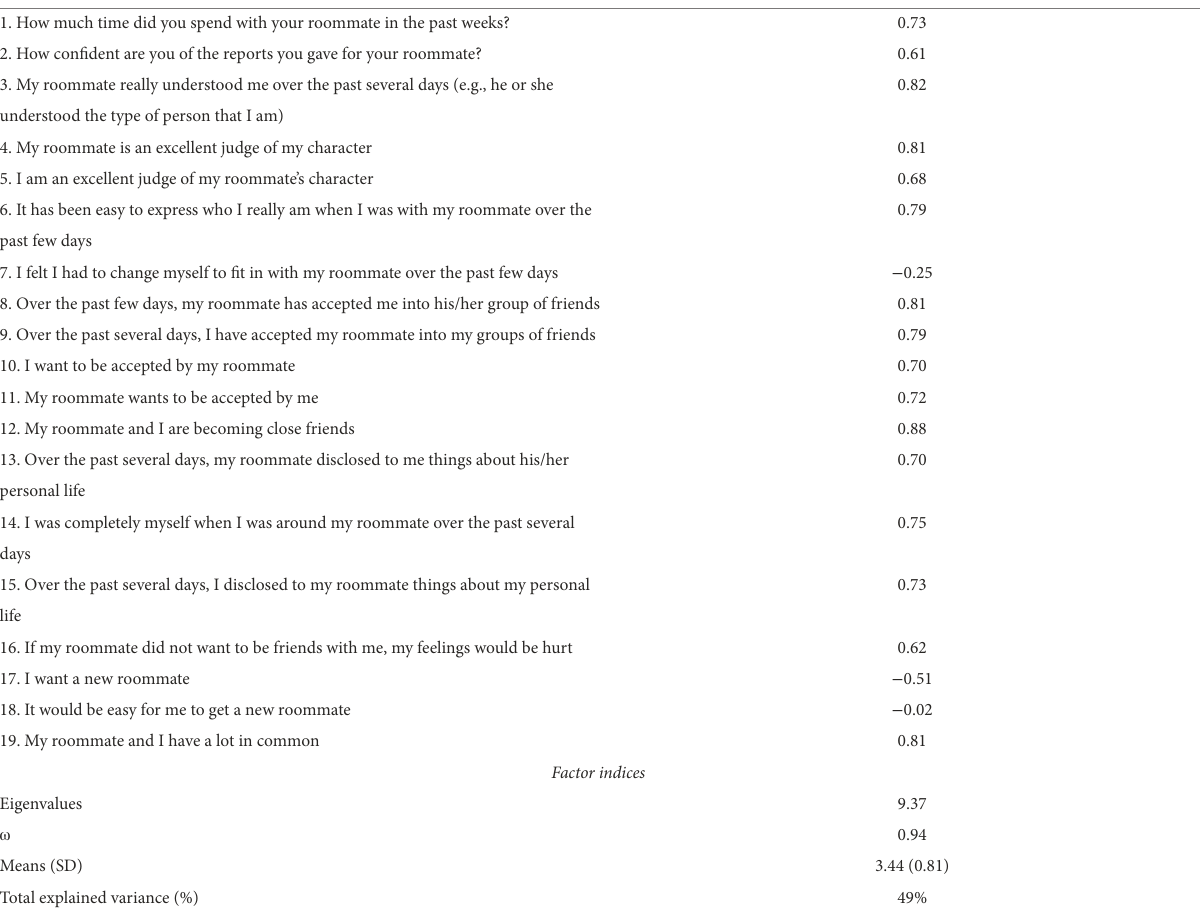
TABLE 6 Exploratory factor analysis of the 19-item